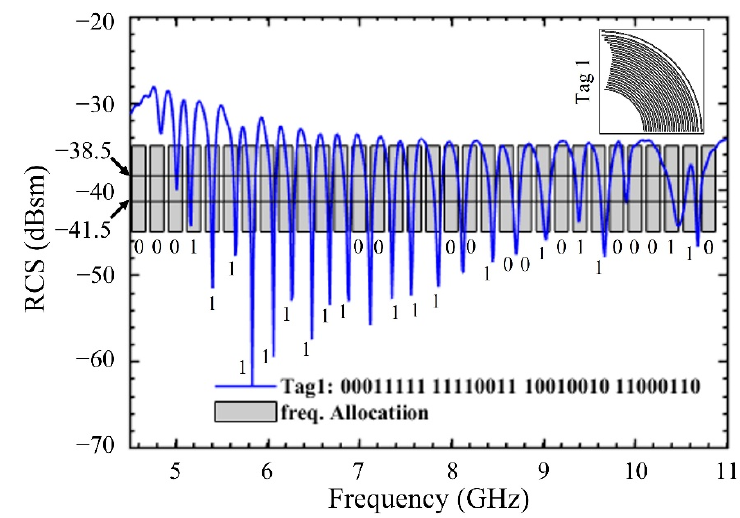
Figure 4. Simulated RCS response of Tag 1.